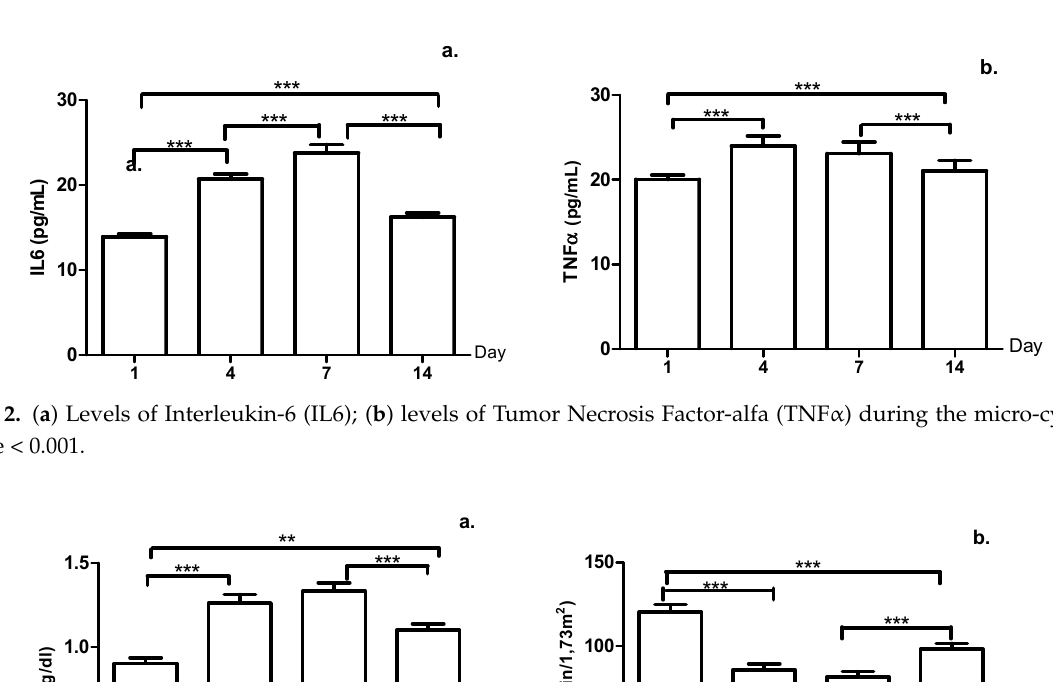
Figure 1. ( a ) Superoxide dismutase (SOD) levels. ( b ) Total antioxidant capacity (Cap antiox tot) during the micro-cycle, **: p -value < 0.01, ***: p -value < 0.001.